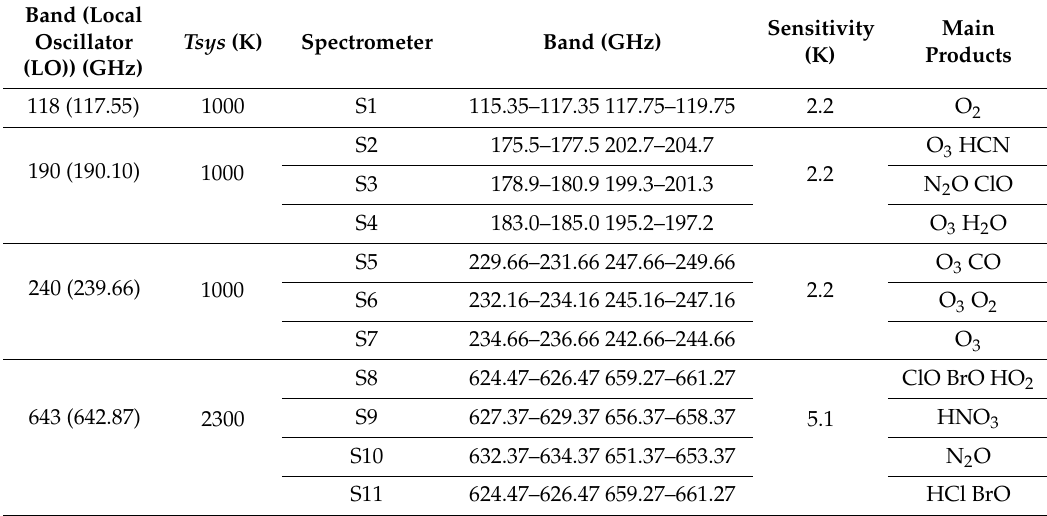
Table 1. Characteristics of the THz atmospheric limb sounder (TALIS) instrument.